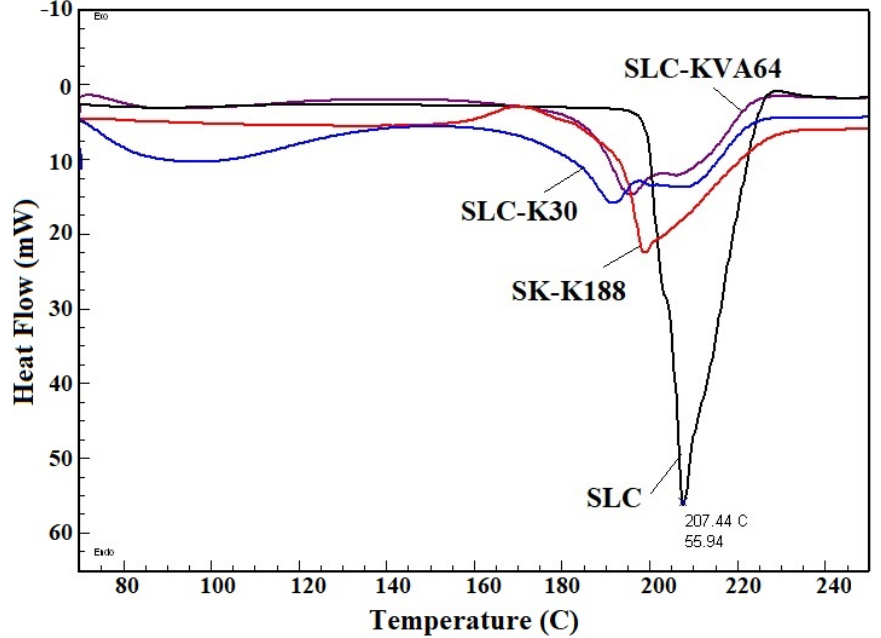
Figure 2. Comparative DSC thermogram of pure SLC, SLC-K188, SLC-K30, and SLC-KVA64.